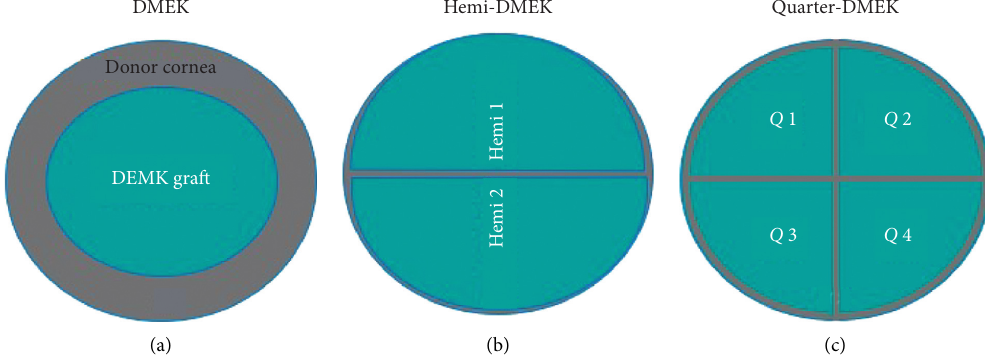
Figure 1: Comparison of graft diameter in DMEK (8.5 to 9.5 mm), hemi-DMEK (11-12 mm × 5-6mm), and quarter-DMEK (6mm × 5 mm) (based on the articles by Lam et al. and M¨uller et al. [19,